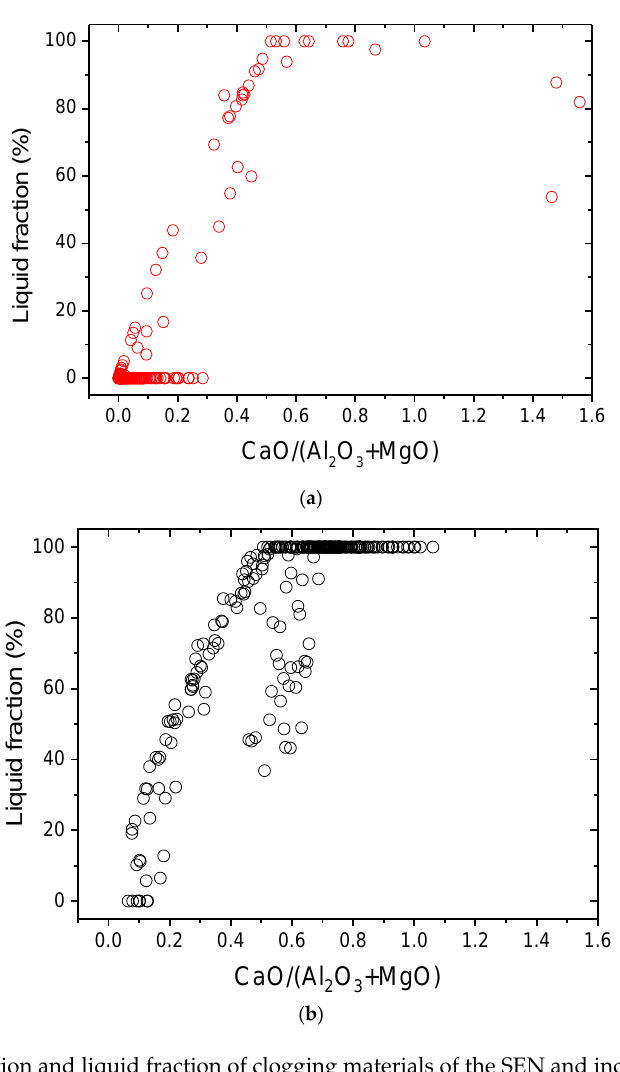
Figure 7. Composition and liquid fraction of clogging materials of the SEN and inclusions in the steel: ( a ) clogging materials, ( b ) inclusions in the steel.